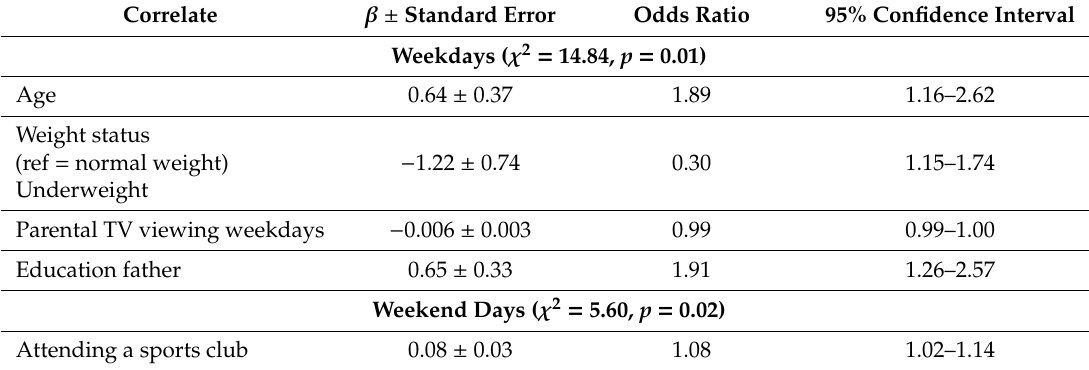
Table 3. Results of the final multilevel logistic regression analyses, with meeting physical activity, sedentary behavior, and sleep guidelines as the dependent variables, separately for weekdays and weekend